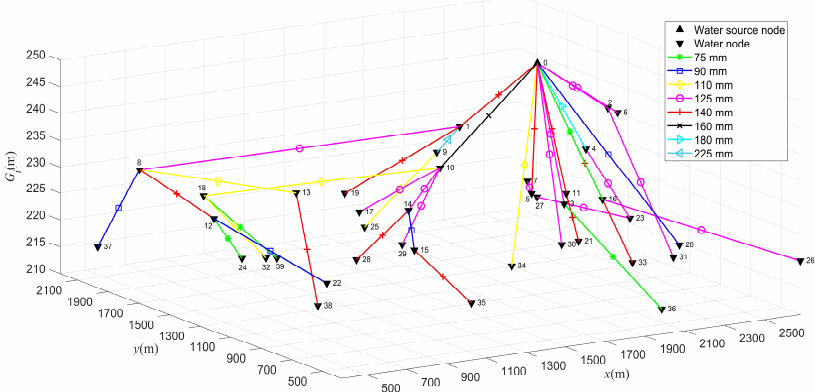
Figure 6. Optimal design results for the pipe network based on the ICSO-ASV algorithm (40 nodes, 3D). Different colors represent different pipe diameters, as shown in the key.